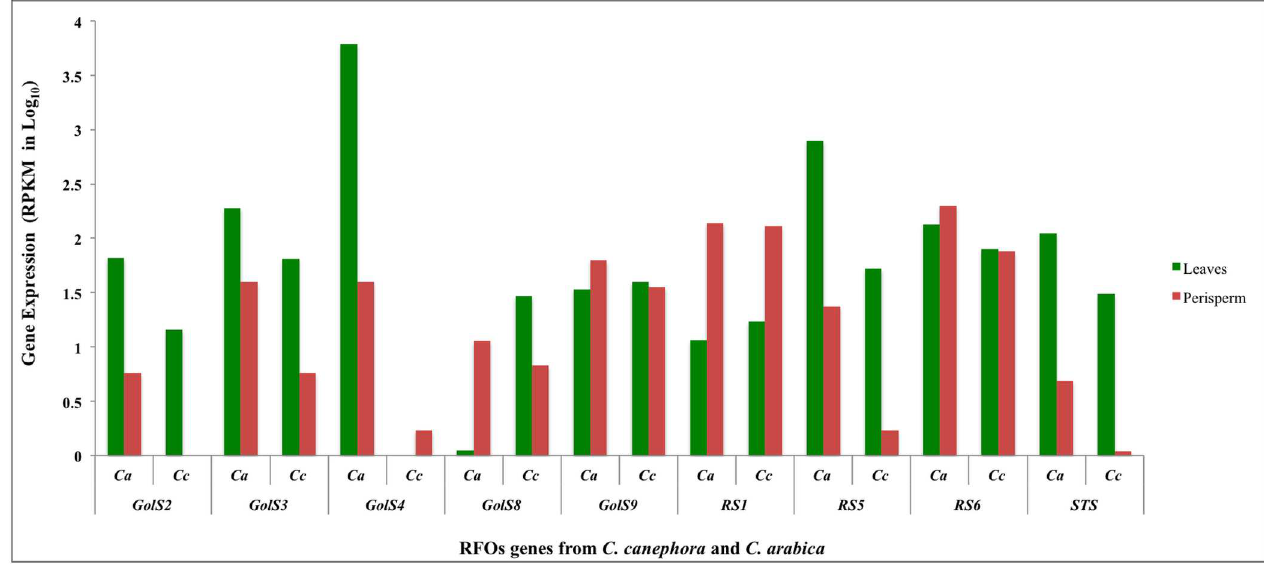
Fig 3. DGE comparison of raffinose biosynthesis-related genes in leavesand perispermbetween C . arabica and C . canephora . RPKM values are representedin Log 10 scale. Leaves noted in green, and perisperm in red. Ca = C . arabica . Cc = C . canephora . C . canephora RPKM values were obtainedfrom the Coffee Genome Hub